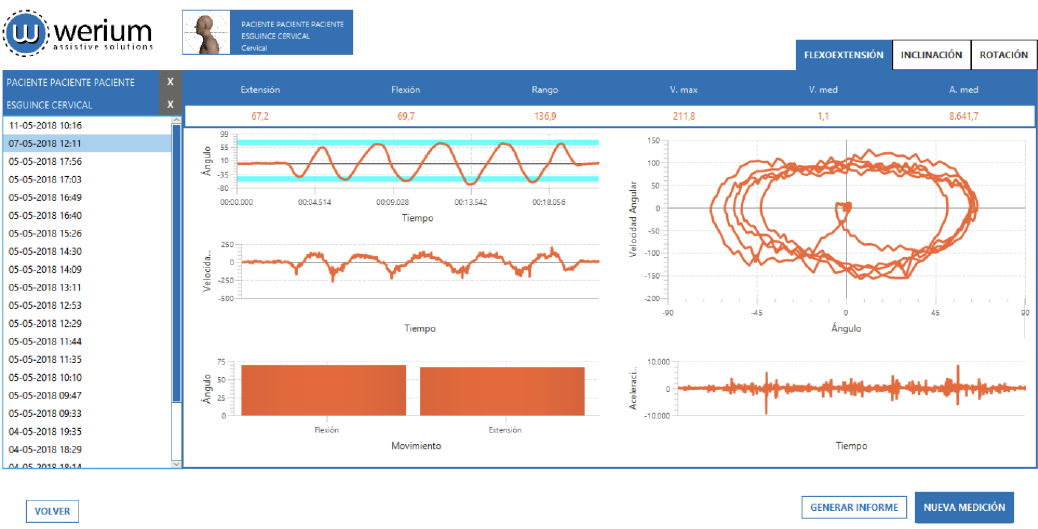
Figure 5. Sample CROM